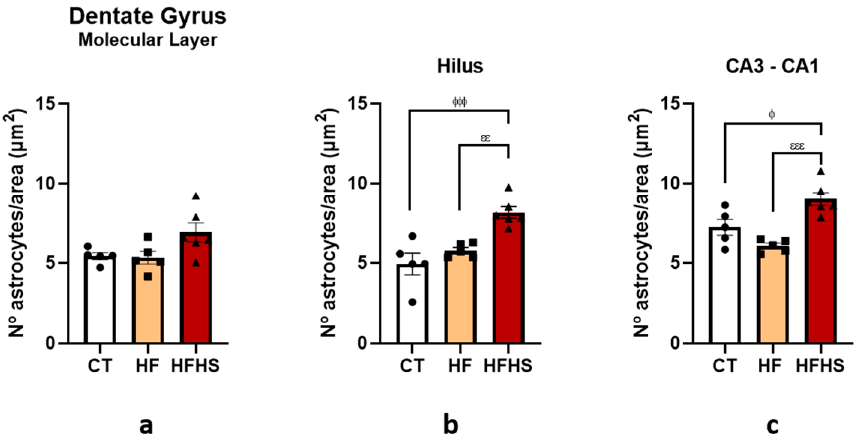
Figure 12. Histograms showing the mean ± SD number of astrocytes per area in the molecular layer ( a ), hilus ( b ), and CA3-CA1 ( c ) region. There was a significant increase in the number of astrocytes per area in the hilus and CA3-CA1 regions compared with the control and HF animals. φ p < 0.05; φφφ p < 0.001 HFHS versus controls; εε p < 0.01; εεε p < 0.001 HFHS versus HF animals. The bars in white represent the mean for the control group, the bars in orange represent the mean for the HF group, and the bars in red represent the mean for the HFHS group. The circle represents the value for each animal in the control group, the square represents the value for each animal in the HF group, and the inverted triangle represents the value for each animal in the HFHS group.